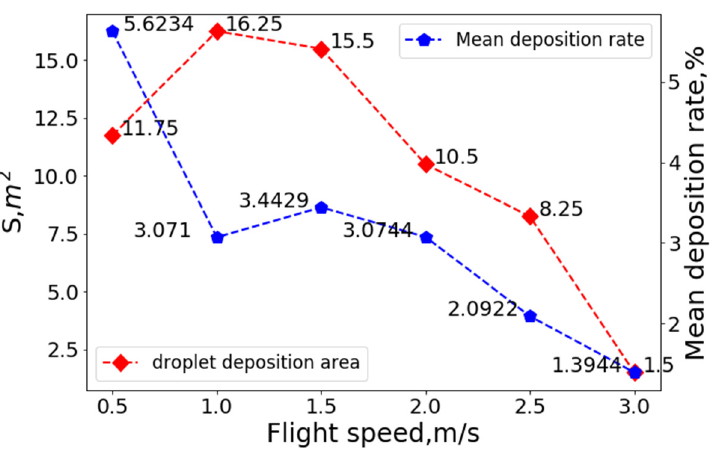
Figure 15. The variation curves of the coverage area, S, and mean droplet deposition rate at a flight height of 3 m, crosswind speed of 0 m/s, and different flight speeds.